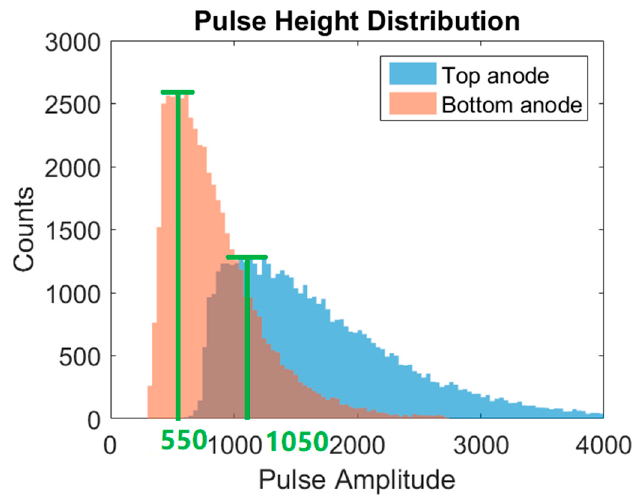
Figure 9. Pulse height distribution of top and bottom XS anodes. Table 2. Inter-electrode capacitance results of simulation and measurement. Top Adjacent Bottom Strips Adjacent Strips